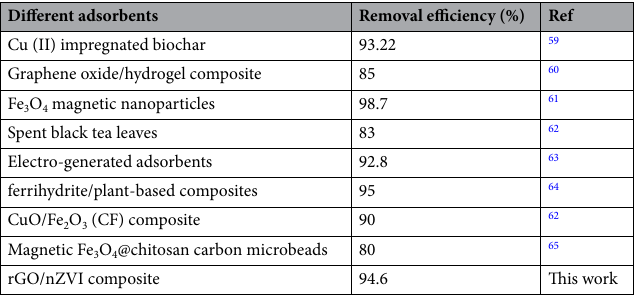
Table 4. Comparison between the maximum adsorption capacities and equilibrium time of DC antibiotics removal onto different reported adsorbents with rGO/nZVI composite of the current study.